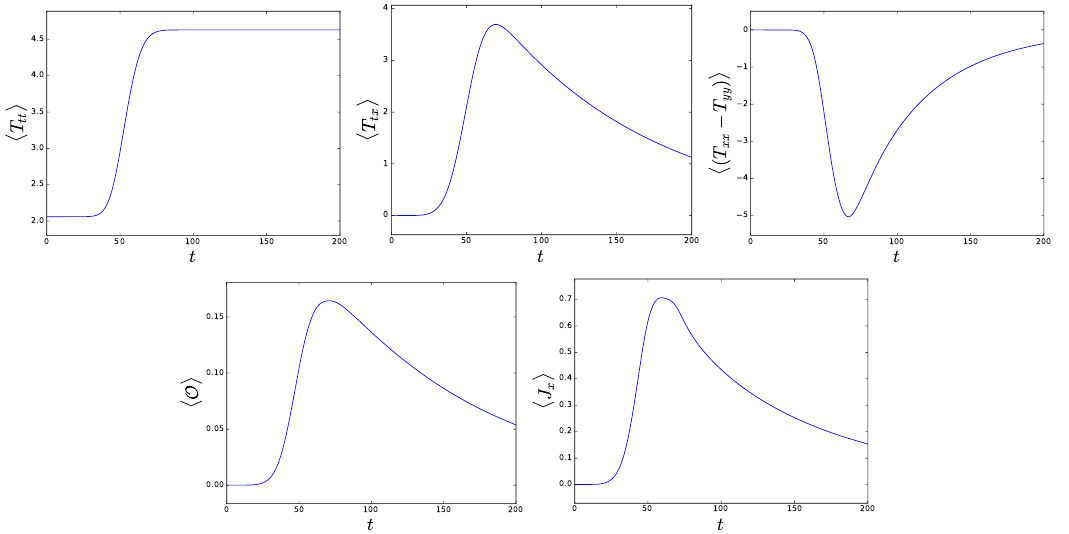
Figure 4 . Time dependence of the expectation value of one point functions the dual (cid:12)eld theory. The parameters considered here are the same of (cid:12)gure